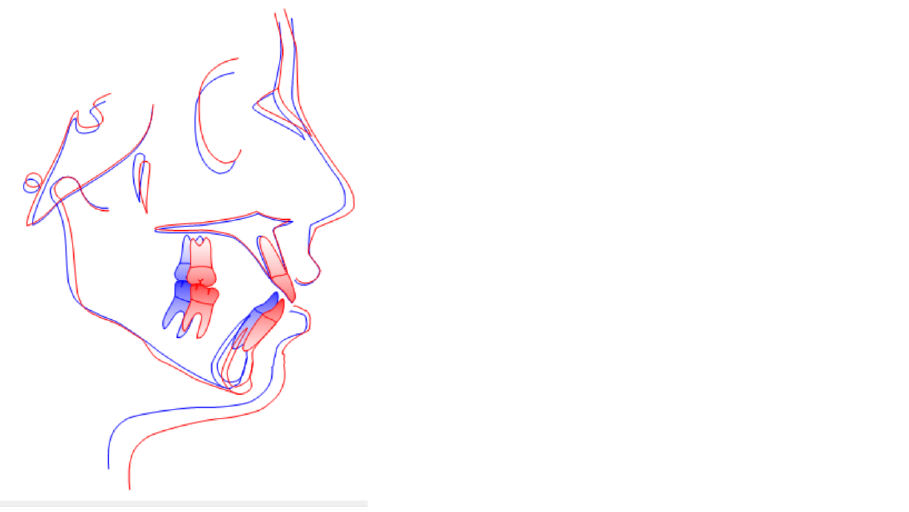
Figure 16. Cephalometric superimpositions (blue, pre treatment; red, post treatment).